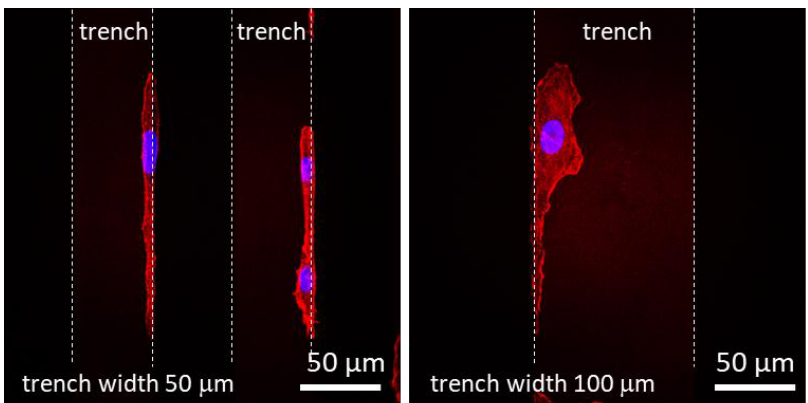
Figure 11. Fluorescence confocal micrographs of adherent cells elongated on the 50 and 100 μm wide trenches at the trench sidewall and bottom junctions. Dash lines correspond to the trench boundaries.